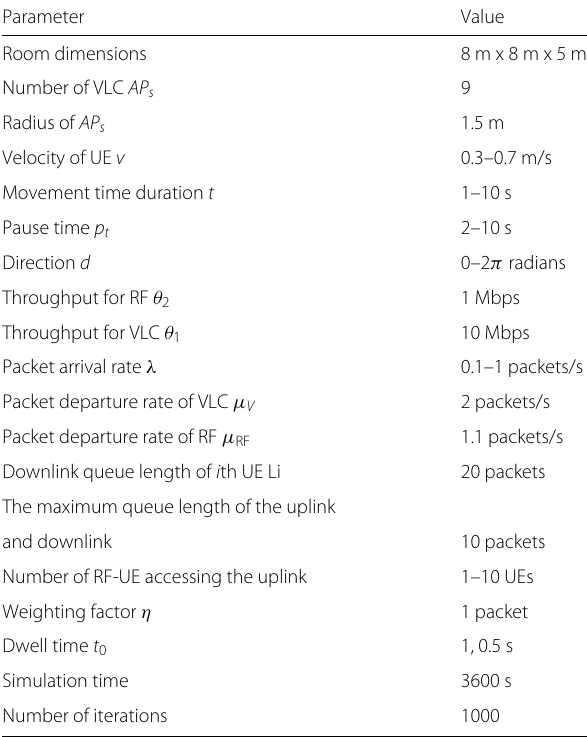
Table 1 Simulation